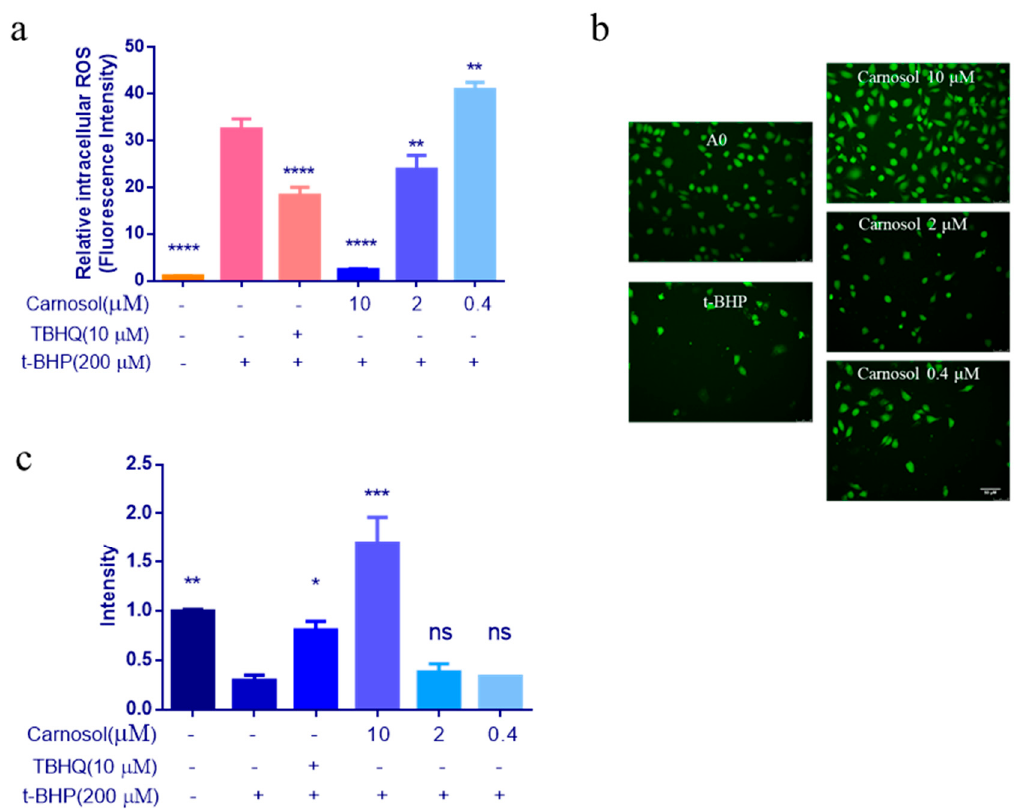
Figure 5. Effects of carnosol in ROS and NO assays. ( a ) The levels of intracellular ROS were measured using DCFH-DA fluorescent probe. ( b – c ) The levels of intracellular NO were measured using DAF-FM DA fluorescent probe. It was used a fluorescence microscope to take photos at 20 × magnification. * p < 0.05, ** p < 0.01, *** p < 0.001, **** p < 0.0001, ns: no significant difference. 200 µ M t-BHP-treated as model group, TBHQ (10 µ M) was used as a positive control group, 0.25% DMSO-treated as a negative control group, all groups were compared with the model group (no carnosol, no TBHQ, with 200 µ M t-BHP).